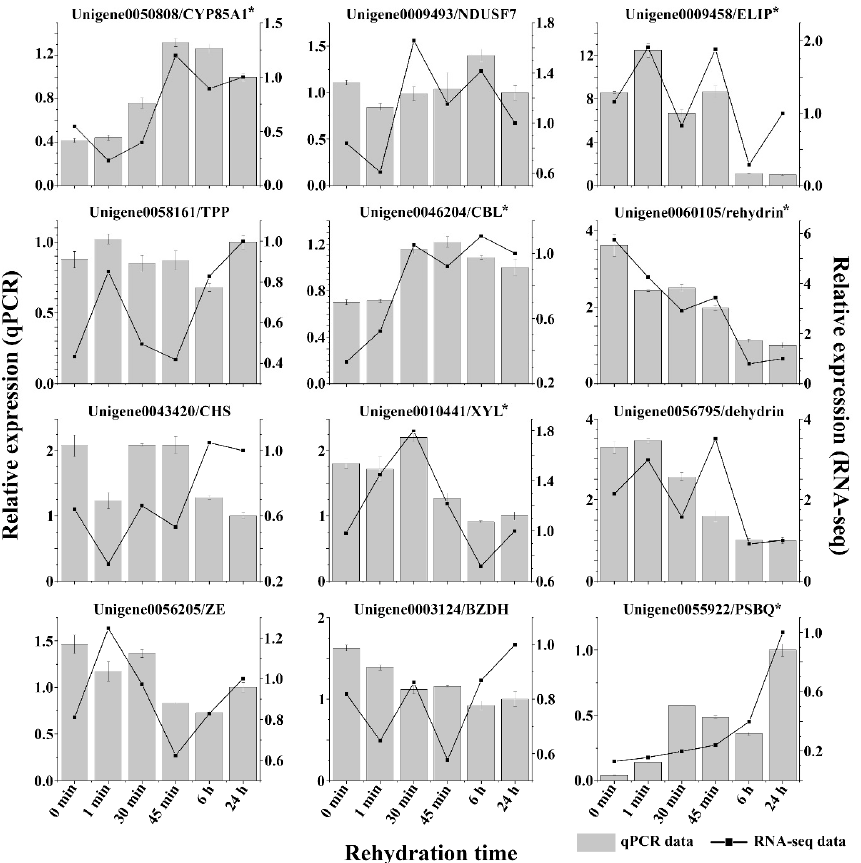
Figure 6. Validation of relative expression levels of unigenes from RNA-seq data using quantitative real-time PCR (qPCR). Relative expression levels of 12 DEGs were compared using RPKM values from RNA-seq results (linear graphs) and qPCR results (bar graphs), RPKM value and qPCR result of each unigene in the R. canescens samples rehydrated for 24 h were set to 1. Data are mean value of three replicates, error bars indicate standard deviation. Asterisks (*) indicate the Pearson correlation coefficient between qPCR and RNA-seq data is over 0.8. BZDH: benzaldehyde dehydrogenase,